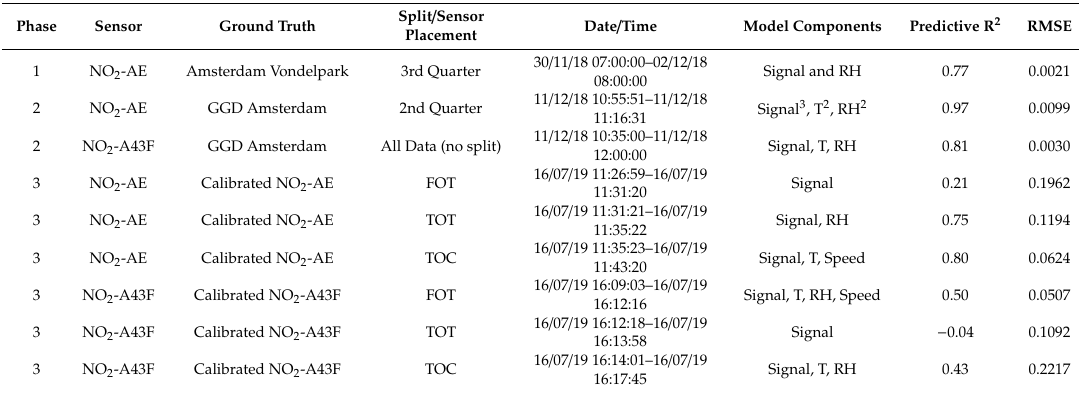
Table 1. Calibration Results for Phase 1, 2, and Stage A of Phase